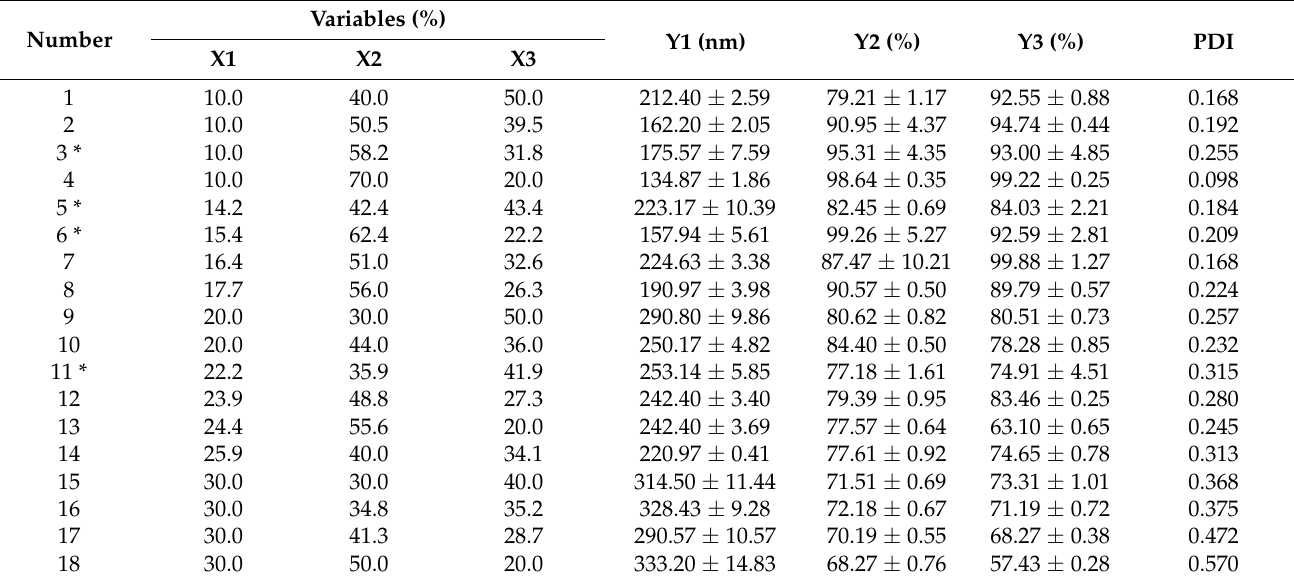
Table 2. Formulations from randomized runs in D-optimal mixture design (Capryol ®